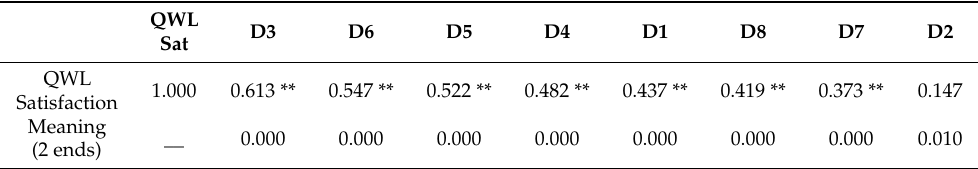
Table 3. Analysis of the correlation between the QWL satisfaction dimensions and the dimensions of the